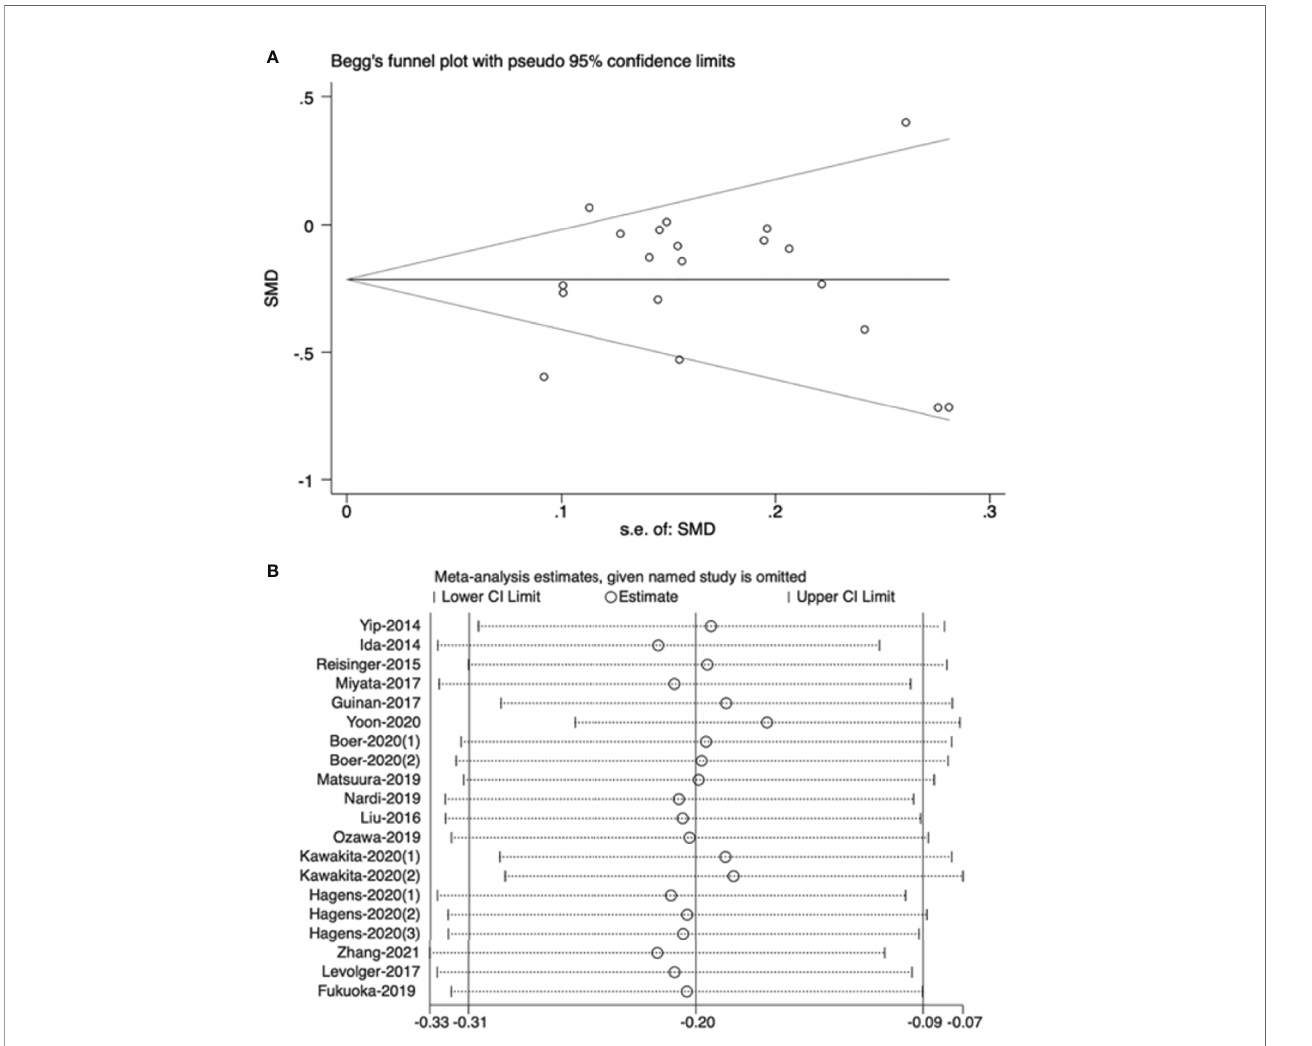
FIGURE 6 | (A) Publication bias of effect of neoadjuvant therapy on muscle mass, (B) Sensitivity analysis of effect of neoadjuvant therapy on muscle